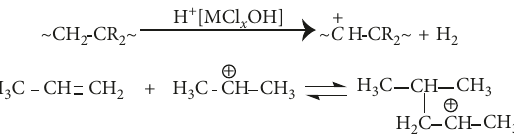
Figure 2: Scheme of the pyrolysis mechanism in the presence of metal chlorides.